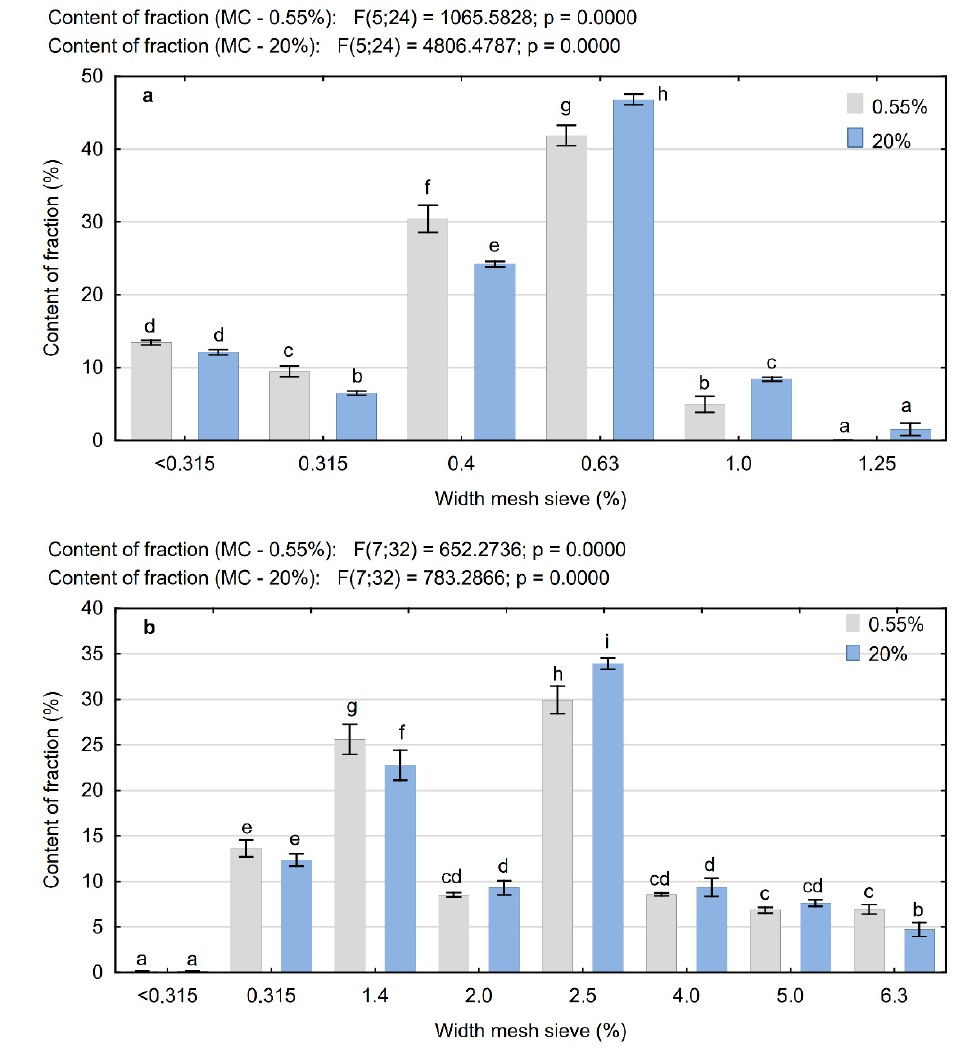
Figure 4. Fractional composition of microparticles ( a ) and particles of the core layer of particleboards ( b ) depending on their moisture content (a, b, c …—homogeneous groups as determined by the Tukey test).